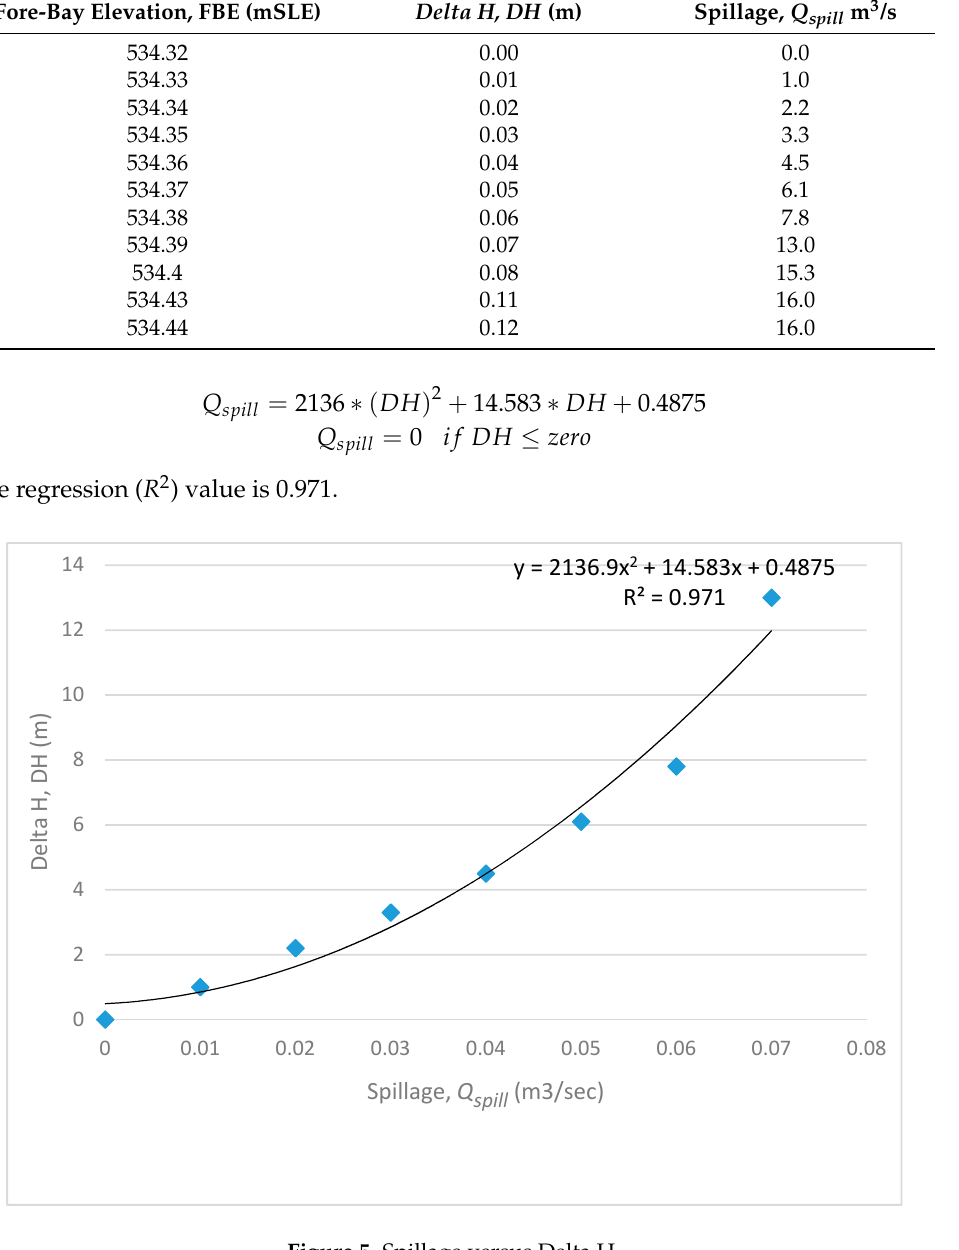
Figure 5. Spillage versus Delta H.